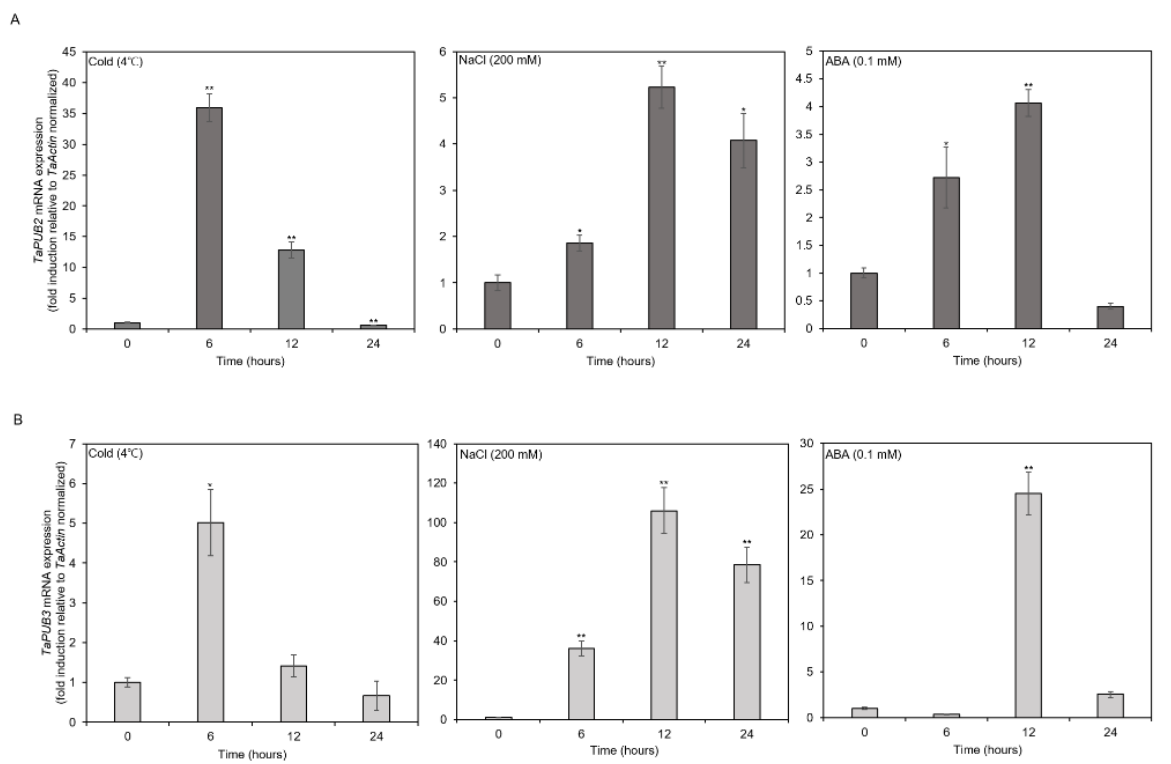
Figure 2. Gene expression patterns of TaPUB2 and TaPUB3 in response to different abiotic stresses (cold (4 ◦ C), salt (200 mM NaCl), and abscisic acid (ABA) (0.1 mM)). ( A , B ) qRT-PCR analysis of TaPUB2 and TaPUB3 under different types of abiotic stresses in wheat leaf tissues. The TaPUB2 and TaPUB3 mRNA expression levels of the genes are presented as the mean ± SD of three biological replicates. TaActin2 was used as the control. Asterisks represent statistically significant differences based on a two-tailed Student’s t-test when compared to controls (0 h); * p < 0.05, ** p < 0.01.